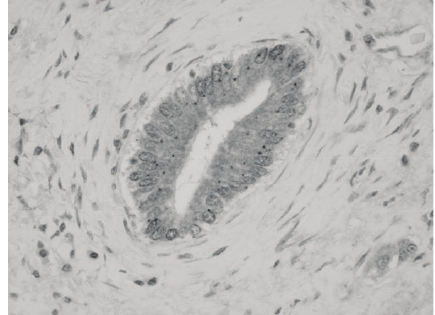
Figure 4: IRAK-M is constitutively expressed in the cytoplasm of septal bile ducts in normal liver. Immunohistochemistry for IRAK-